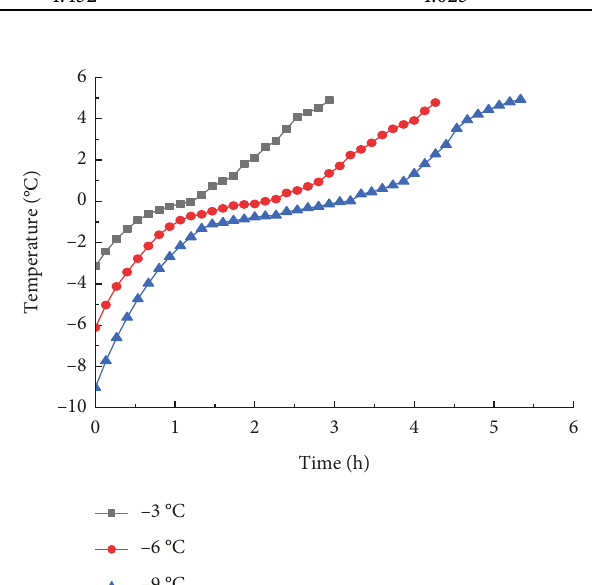
Figure 6: Temperature change curve of the surface of the test specimen at different ambient temperatures.